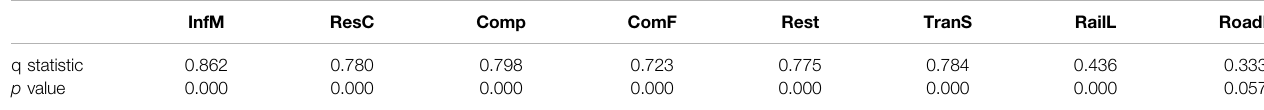
TABLE 4 | Power of determinant (q) for the eight factors in fl uencing the COVID-19 epidemic transmission. InfM